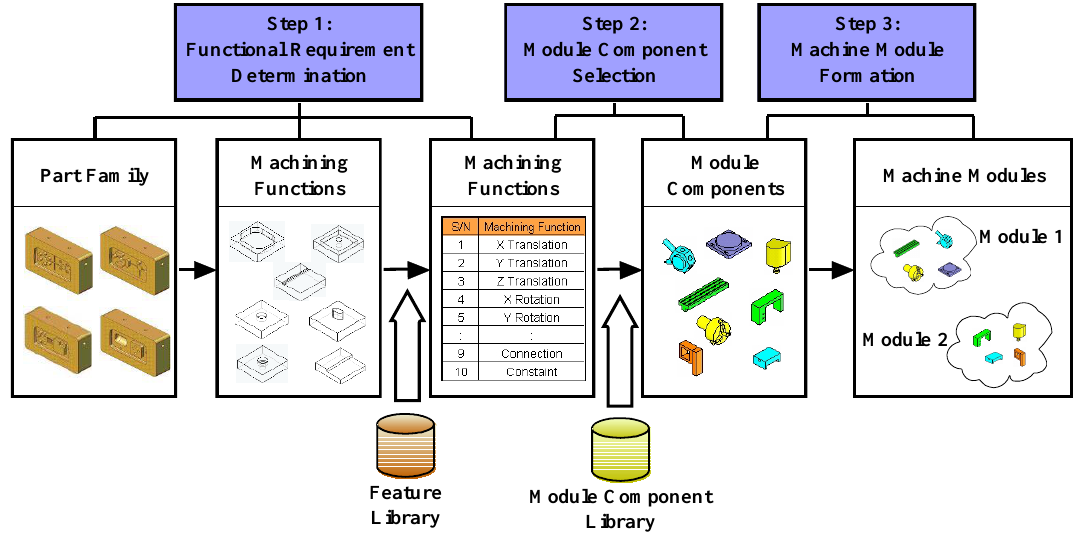
Figure 3. Flowchart of the module selection method.